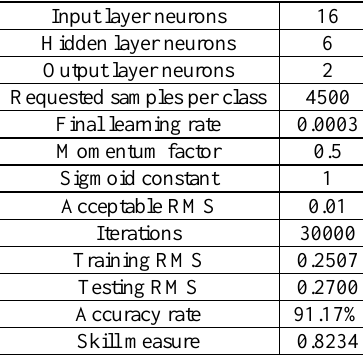
Table 1. The MLP parameters and